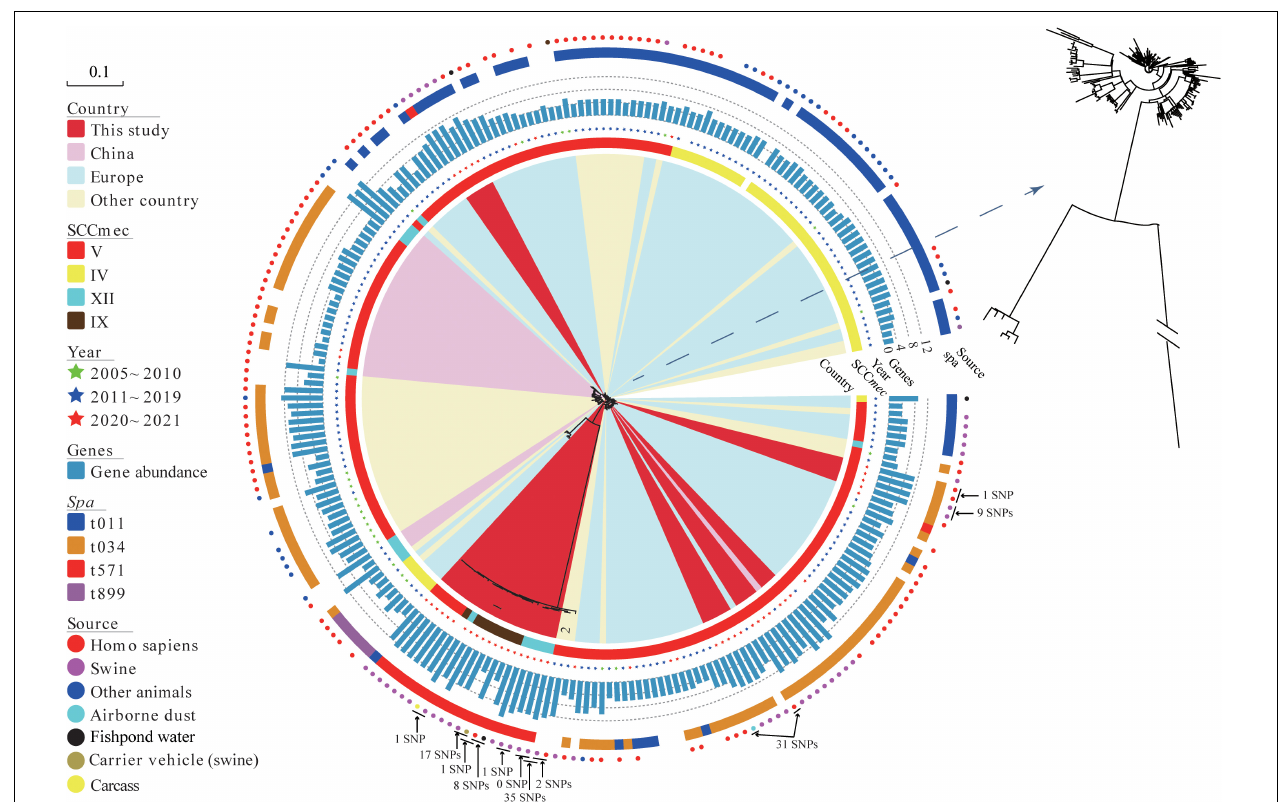
FIGURE 3 | The maximum likelihood (ML) phylogenetic tree of 42 methicillin-resistant Staphylococcus aureus (MRSA) ST398 isolates from China based on single nucleotide polymorphisms in the core genomes. A total of 197 global MRSA ST398 isolates were included for comparison. Regions were indicated by leaf color. Sources and years of the isolates were indicated by circles and stars in different colors, respectively. SCC mec and spa types were indicated by strips in different colors. The branch of Block 2 represents Korean isolates. The total number of antibiotic resistance genes in each isolate was represented by the length of a blue bar chart. Details of the genes of each isolate are given in Supplementary Table 7 . The core of phylogenetic tree was amplified for a clearer display.